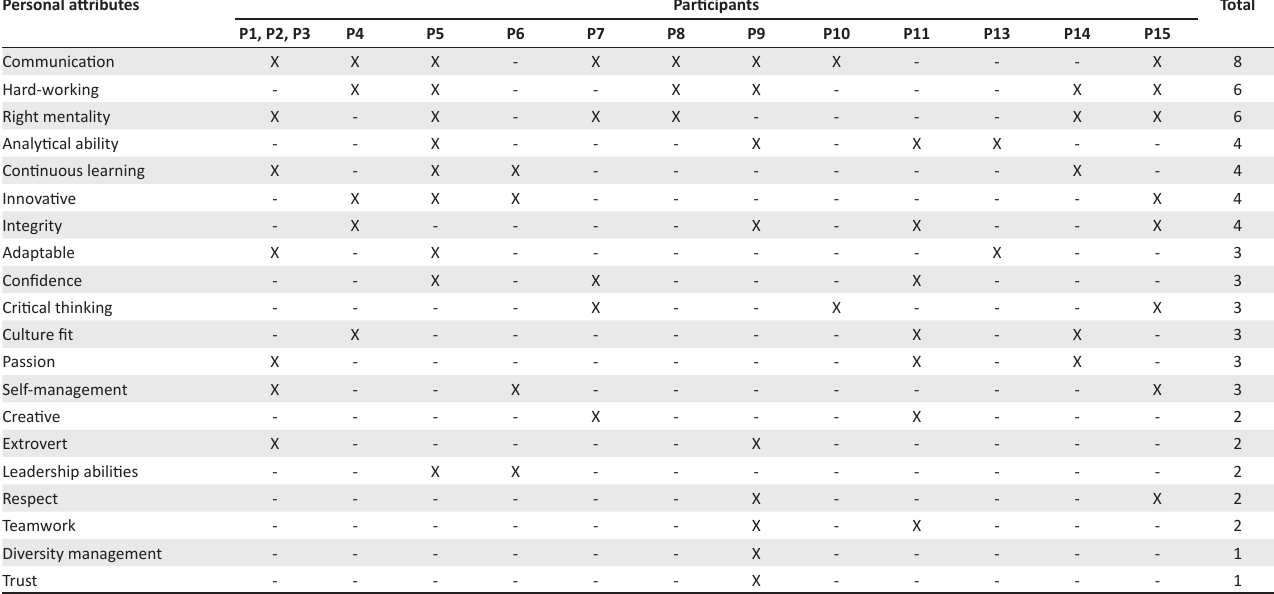
TABLE 8: The industry’s expectation concerning personal attributes needed. Personal